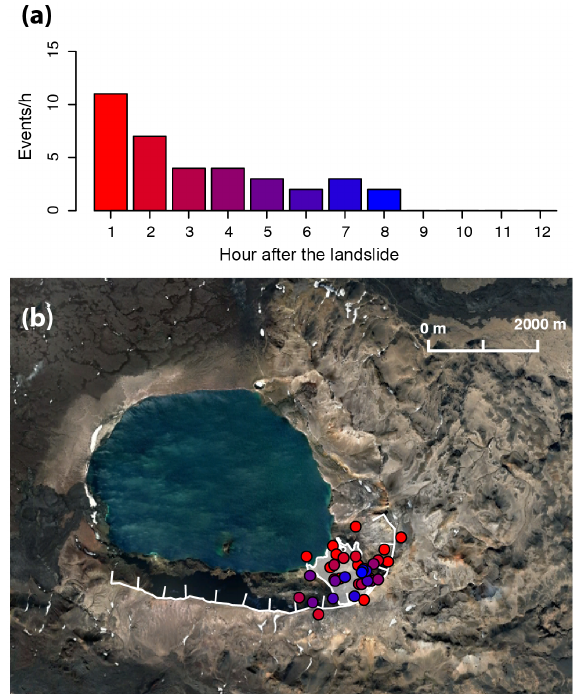
Figure 9. (a) Number of small slope failures after the Askja land- slide per hour. (b) Location of small slope failures after the Askja landslide, colour-coded by hour of occurrence as in panel (a) . Only the best-fit locations are shown; the ellipses of the likelihood quan- tile are omitted for clarity (cf. Fig. 7a). The white area at the caldera ring fault is the landslide source